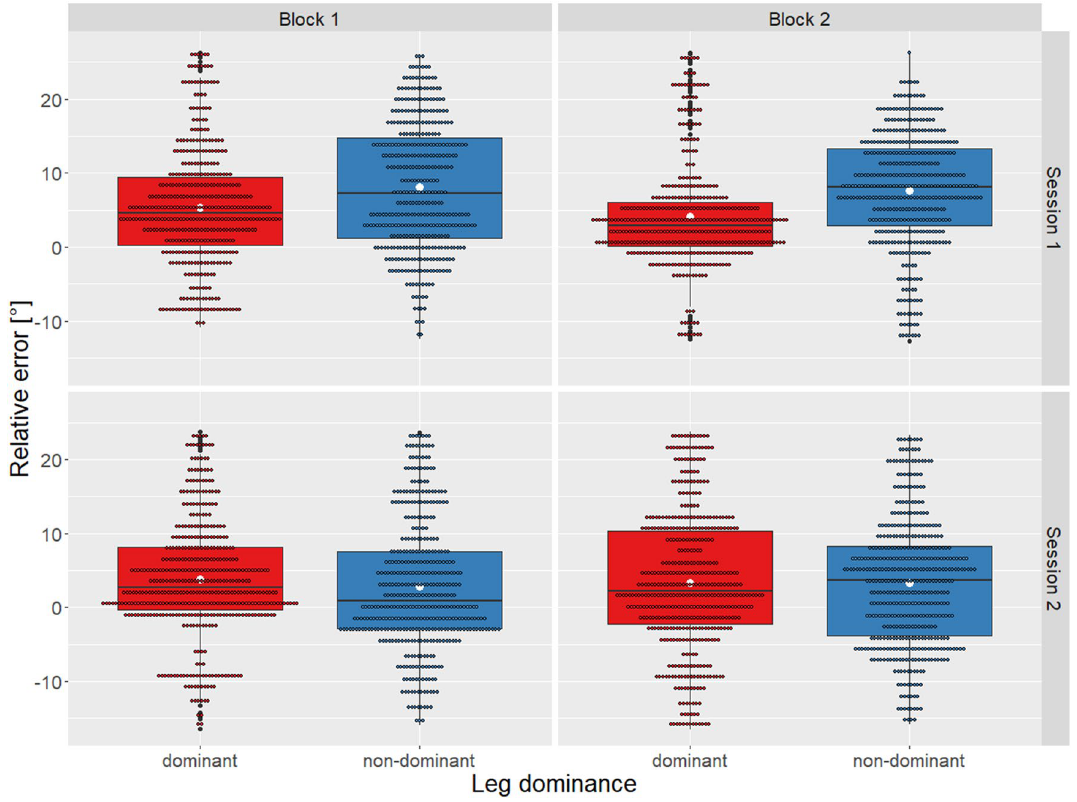
Figure 1. Constant error per leg dominance, session and block. Displayed as boxplots showing additional mean (white dot), outliers (bold black dot) and individual trials (small